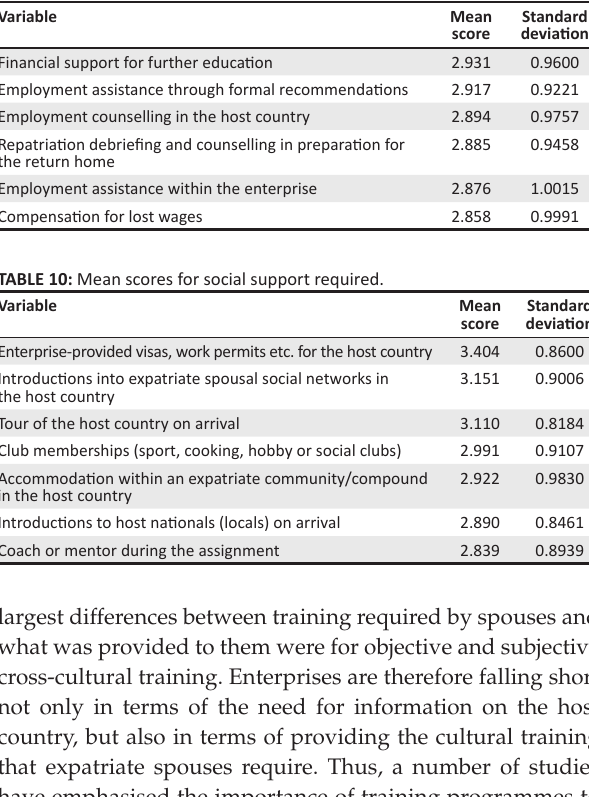
TABLE 7: Mean scores for preparation required.